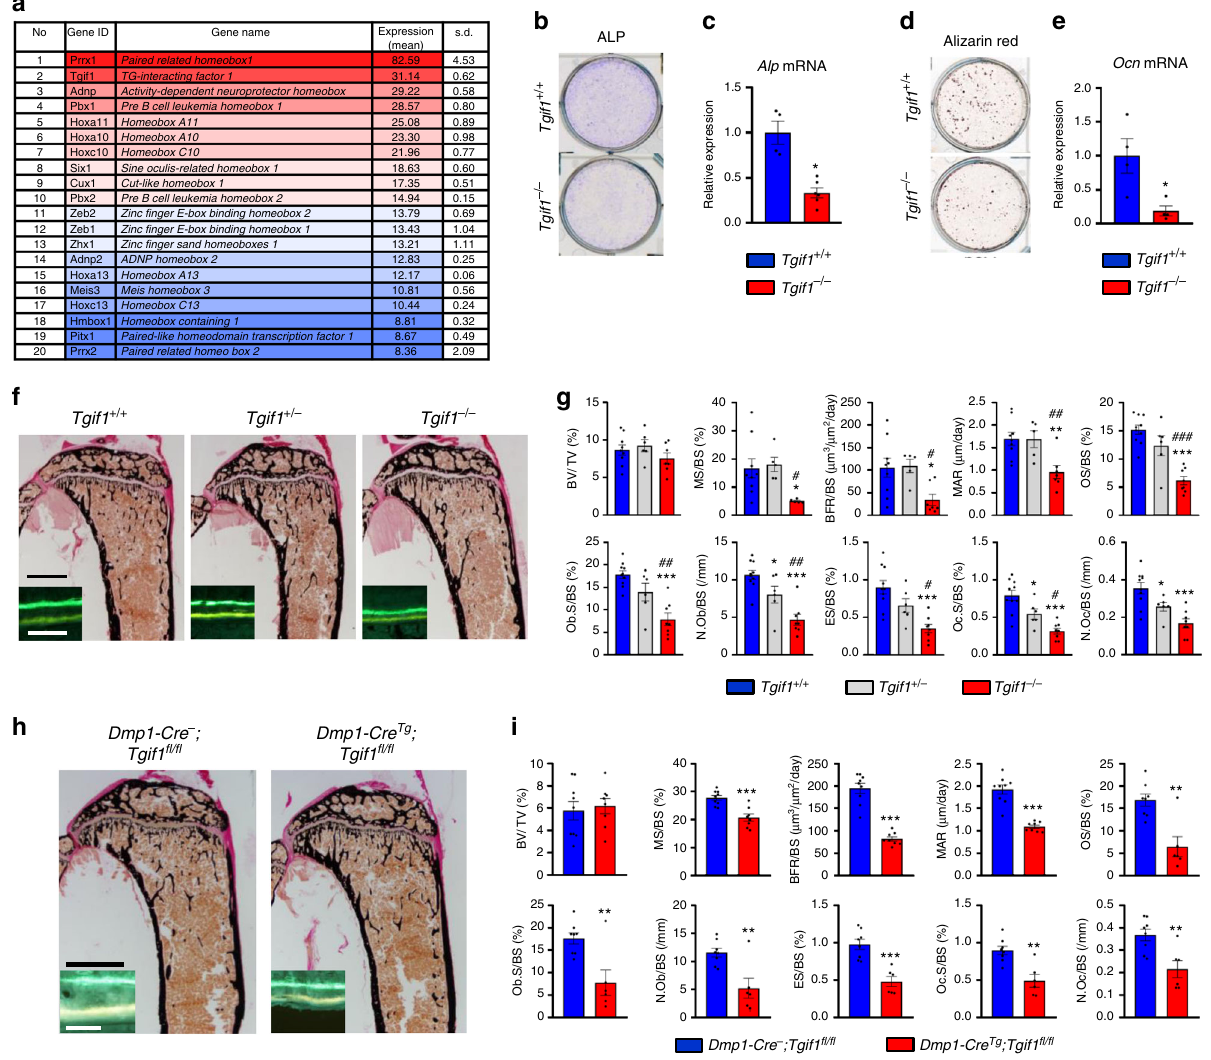
Fig. 1 Deletion of TG-interacting factor 1 (Tgif1) in osteoblasts reduces osteoblast differentiation and bone remodeling. a Homeodomain proteins listed according to their expression in mouse bone marrow stromal cells (BMSCs) during osteoblast differentiation. Expression is indicated as mean values (arbitrary units) with the respective standard deviation (s.d.) ( N = 3). The fi rst 10 genes are marked in shades of red and the remaining 10 genes are presented in shades of blue. b Staining of alkaline phosphatase (ALP) activity after in vitro differentiation of Tgif1 + / + and Tgif1 − / − calvarial osteoblasts for 14 days (representative image of 3 experiments) and c relative Alp mRNA expression ( N = 4). d Determination of matrix mineralization by Alizarin Red staining after 21 days of differentiation (representative image of 3 experiments) and e relative osteocalcin ( Ocn ) mRNA expression ( N = 4). f Representative images of proximal tibiae of 8-week-old male mice with the genotypes Tgif1 + / + , Tgif1 + / − and Tgif1 − / − after von Kossa staining and fl uorescence double labeling to visualize bone formation (insets). g Histomorphometric analysis of the proximal tibiae of 8-week-old male Tgif1 + / + , Tgif1 + / − and Tgif1 − / − mice ( N = 10, 6 and 8). BV/TV bone volume/tissue volume, MS/BS mineralizing surface/bone surface, BFR/BS bone formation rate/bone surface, MAR